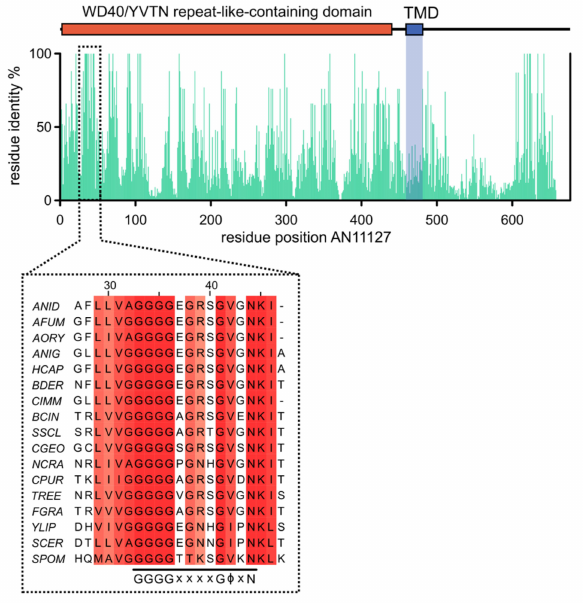
Figure 1. The schematic diagram represents the position of several features over the length of the AN11127 protein sequence: WD40/YVTN repeat-like-containing domain, residues 2-438 (Interpro IPR015943); transmembrane domain (TMD) spanning residues 459-482, as predicted by PolyPho- bius. The bar plot represents the percentage of residue identity for each position in the sequence of AN11127, among fungal homologs in Ascomycota . Inset: the conserved GGGGxxxxG φ xN K-loop mo- tif ( φ hydrophobic residue). Multiple sequence alignment with Clustal Omega of AN11127 homologs found in 16 representative Ascomycota taxa. Numbers indicate amino acid position for the AN11127 protein sequence. Initials, organism and gene ID: ANID, Aspergillus nidulans (AN11127); AFUM, As- pergillus fumigatus (Afu5g05910); AORY, Aspergillus oryzae (AO090009000671); ANIG, Aspergillus niger (ASPNIDRAFT2_1165851); HCAP, Histoplasma capsulatum (HCDG_05382); BDER, Blastomyces dermati- tidis (BDCG_09211); CIMM, Coccidioides immitis (CIMG_06226); BCIN, Botrytis cinerea (Bcin03g02920); SSCL, Sclerotinia sclerotiorum (sscle_03g025460); CGEO, Cenococcum geophilum (K441DRAFT_669274); NCRA, Neurospora crassa (NCU00379); CPUR, Claviceps purpurea (CPUR_05573); TREE, Trichoderma reesei (TRIREDRAFT_121774); FGRA, Fusarium graminearum (FGRAMPH1_01G22837); YLIP, Yarrowia lipolytica (YALI0_A08646g); SCER, Saccharomyces cerevisiae (SEC12/YNR026C); SPOM, Schizosaccha- romyces pombe